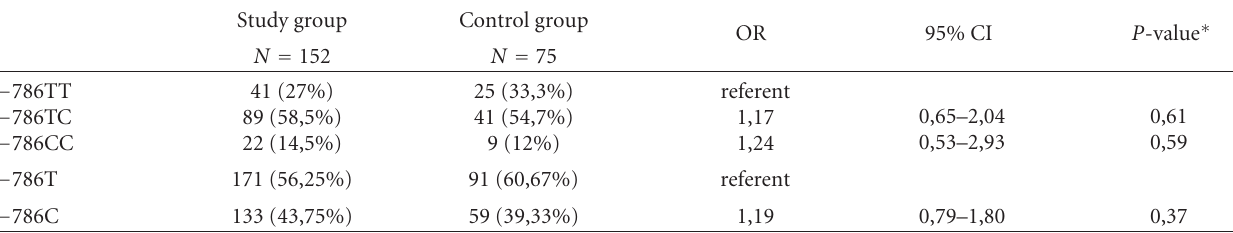
Table 2: Genotype and allelic frequency in study group and control